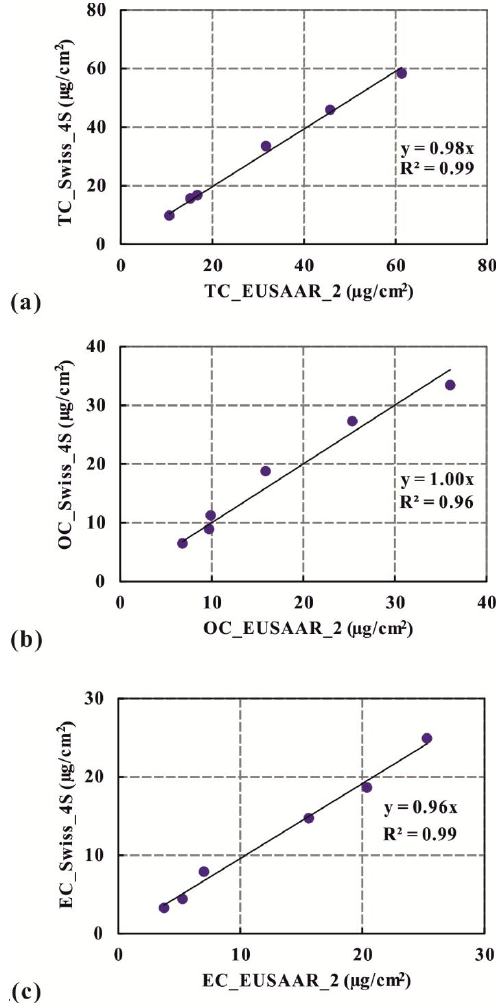
Fig. 8. Comparisons between the Swiss 4S and EUSAAR2 proto- cols for the analysis of TC (a) , OC (b) and EC (c) for the water- extracted aerosol